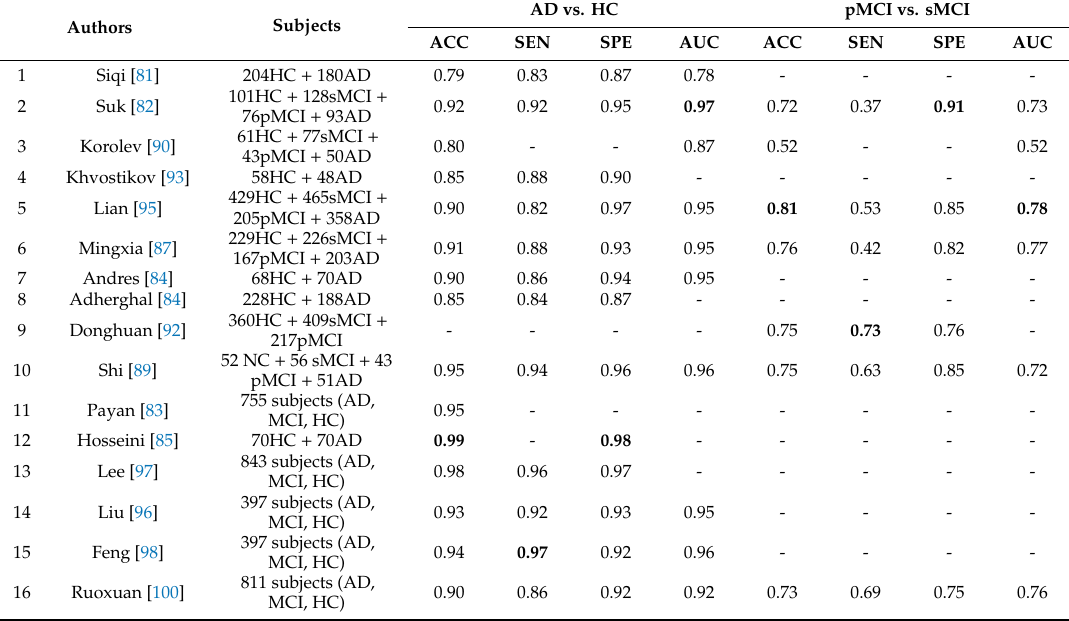
Table 9. A brief review of the state-of-the-art methods for AD classification (AD vs. HC) and MCI conversion prediction (pMCI vs. sMCI) using MRI data. (The best results obtained for di ff erent metrics are highlighted in